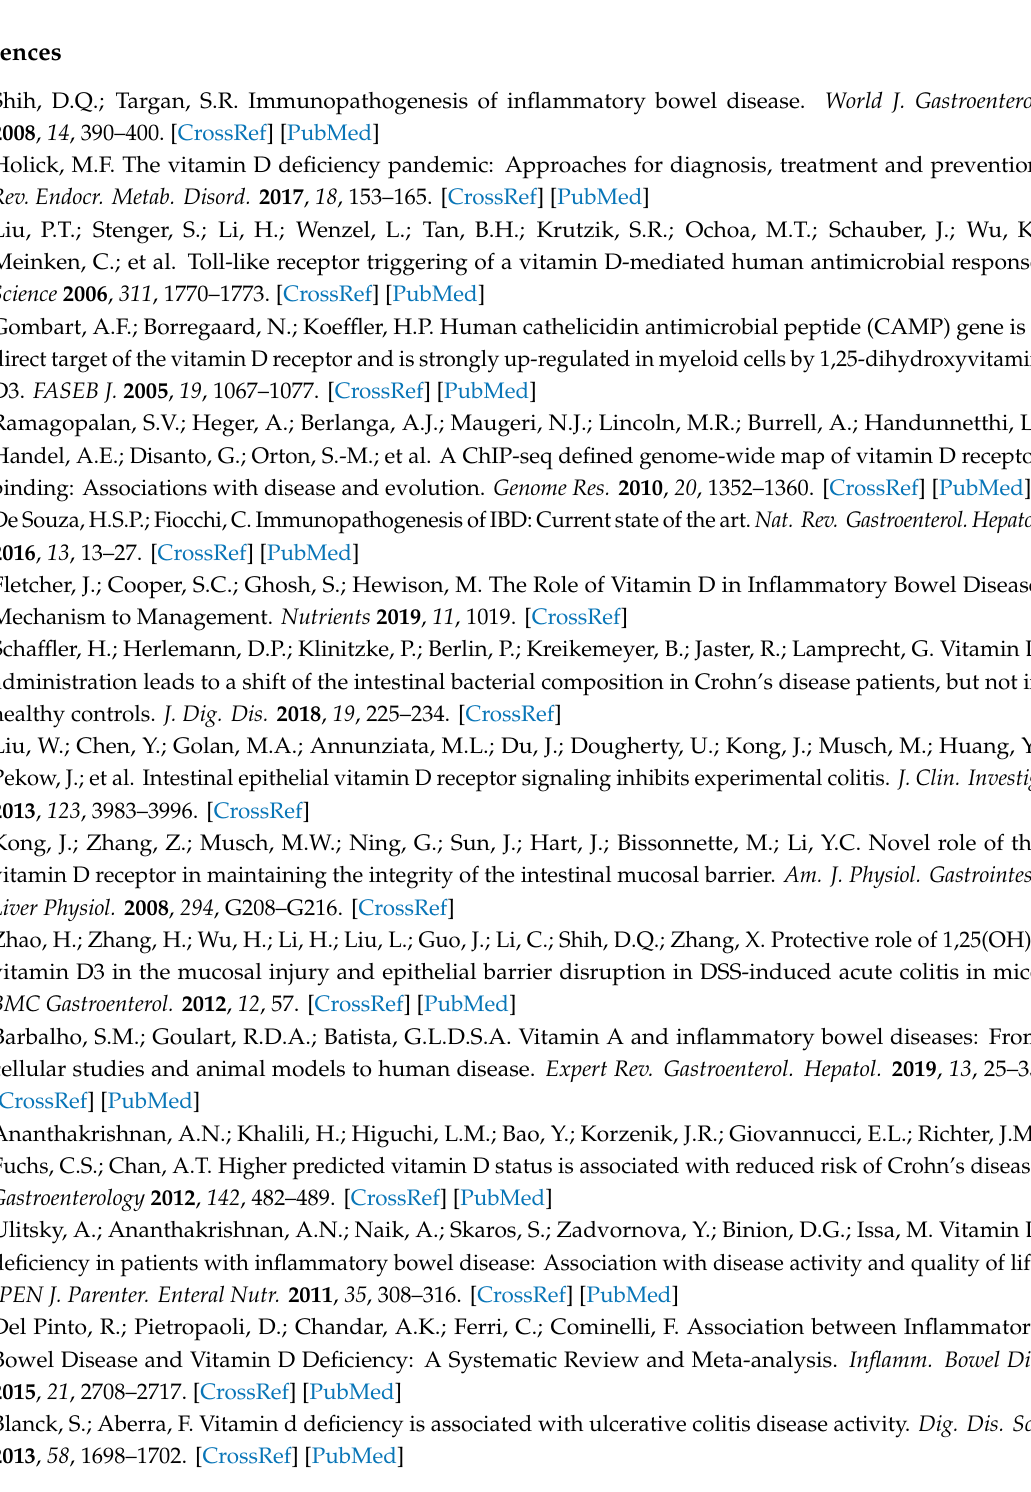
Table S1: Seasonal variations in vitamin D serum